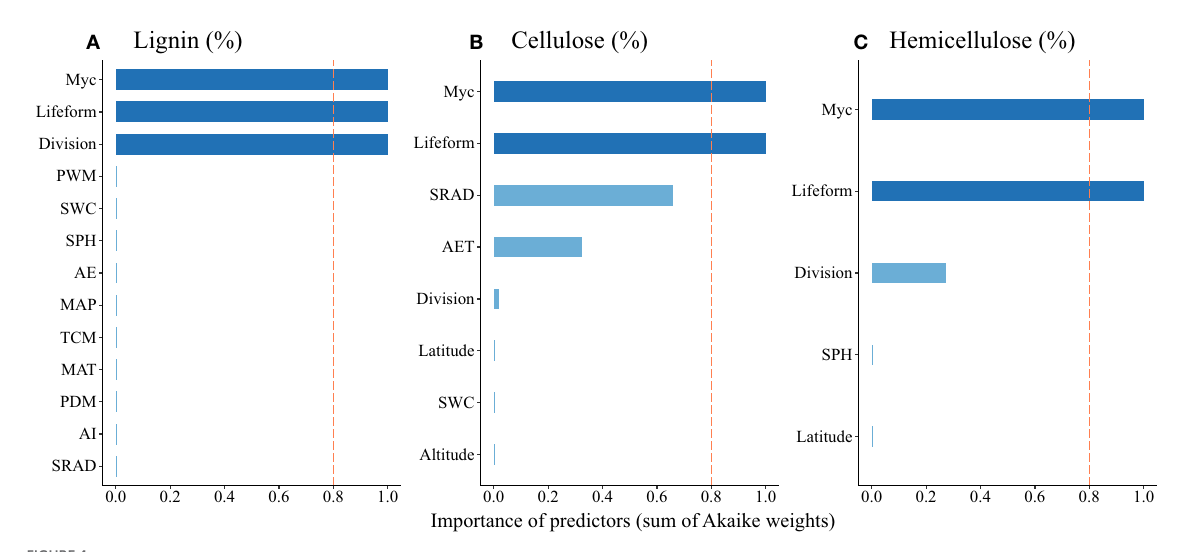
FIGURE4 Model-averaged importance of multiple predictors of litter initial concentrations of lignin (A) , cellulose (B) , and cellulose (C) . Cutoff (red dashed line) is set at 0.8 to explore the essential (deep blue) and non-essential (light blue) predictors. Myc, mycorrhizal association; PWM, precipitation of the wettest month; SWC, soil water content; SPH, soil pH; AET, annual evapotranspiration; MAP, mean annual precipitation; TCM, minimum temperature of the coldest month; MAT, mean annual temperature; PDM, precipitation of the driest month; ADI, aridity index; DSR, daily mean solar